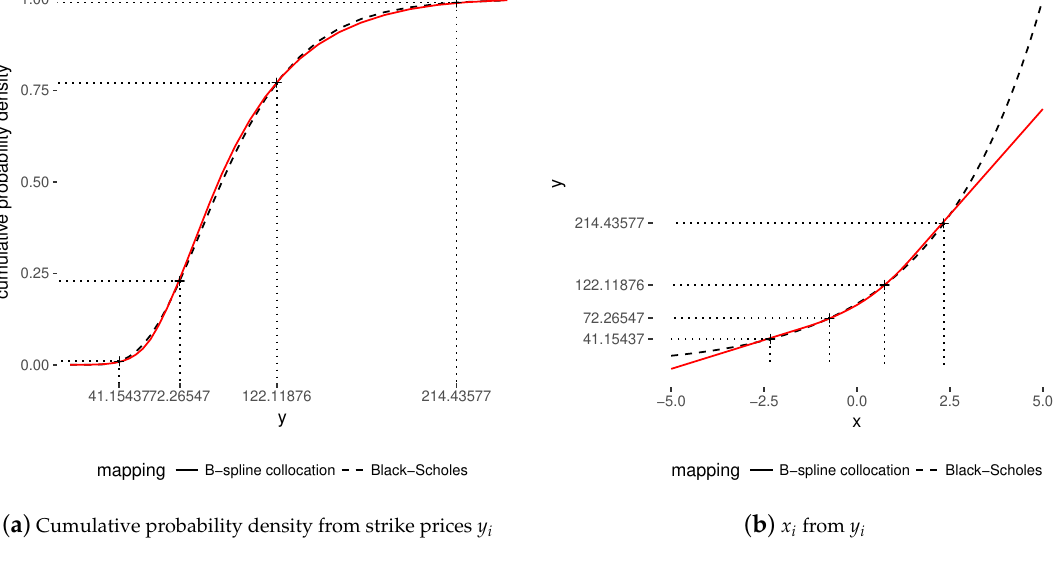
Figure 1. Mapping in the stochastic collocation technique for the Black–Scholes model with volatility σ =